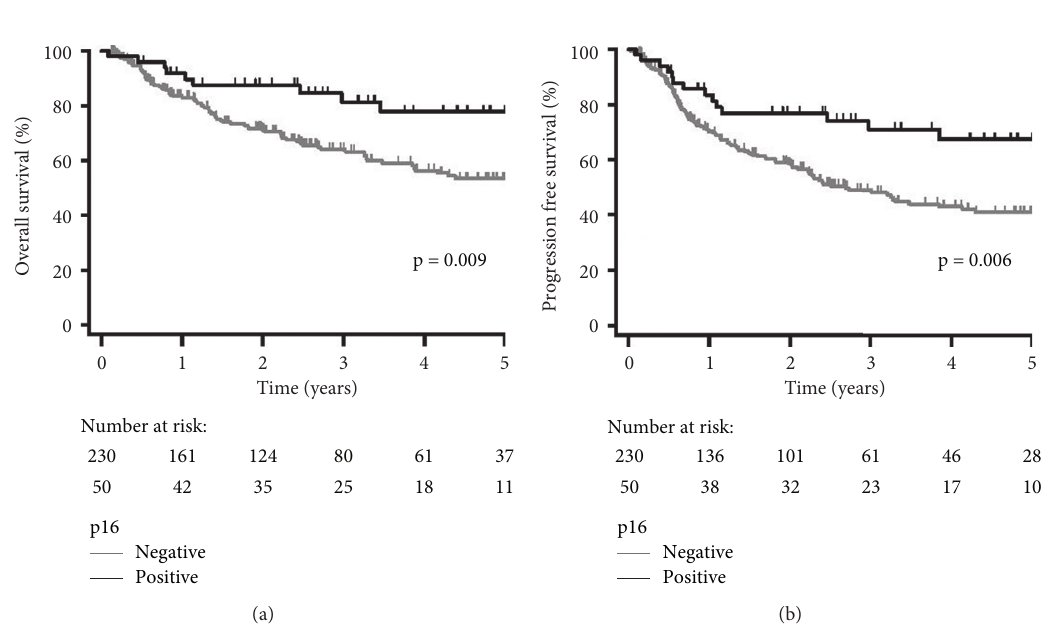
Figure 3: Kaplan–Meier plots stratified by p16 status (positive vs. negative/unknown) for (a) overall survival and (b) progression-free survival for all patients ( n � 280).